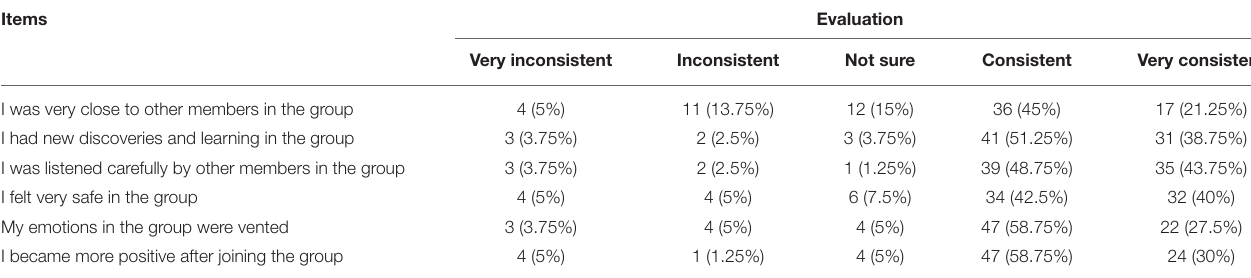
TABLE 5 | Effectiveness evaluation of members on OESAG ( N = 80).